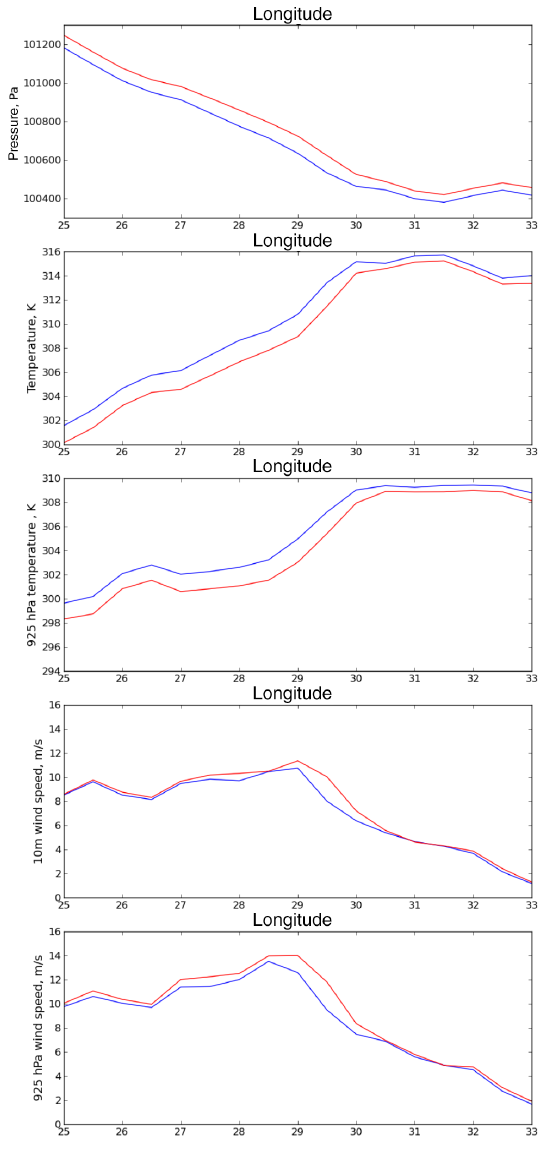
Figure 10. Simulations starting on 17 April 2012, 36h forecast, cross section at 22 ◦ N. Mean sea-level pressure (top), 2m temper- ature (middle top), 925hPa temperature (middle), 10m wind speed (middle bottom) and 925hPa wind speed (bottom) for REF (blue) and SW